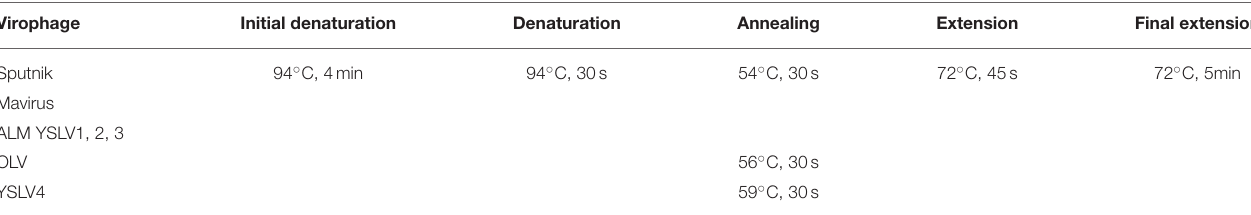
TABLE 3 | Thermal cycling programs of PCR for virophages.